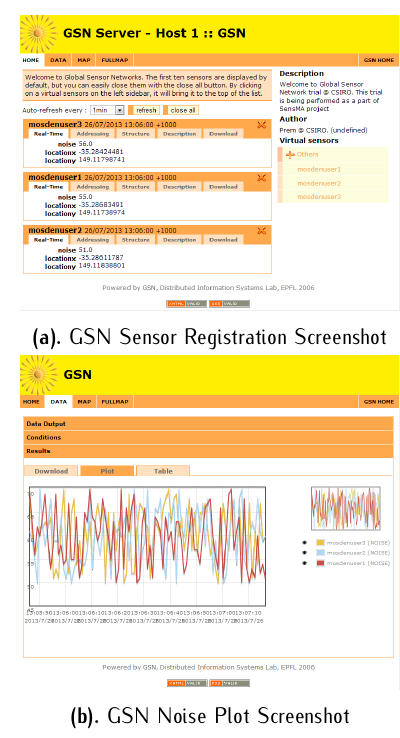
Figure 6. Opportunistic Sensing Noise Pollution Application